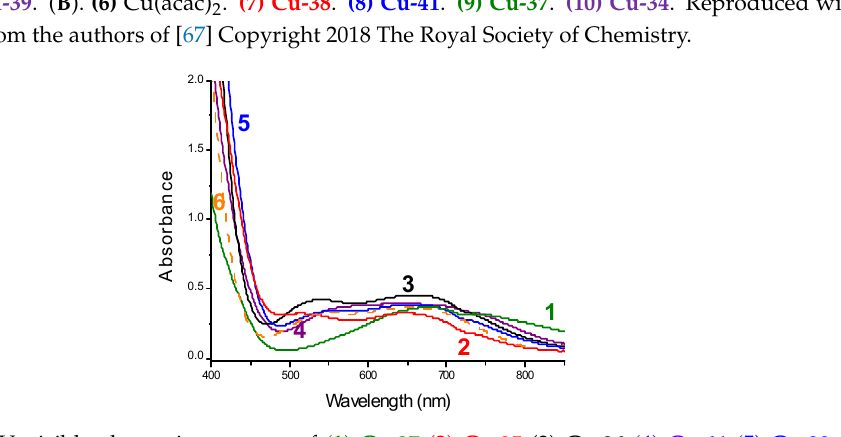
Figure 28. UV–visible absorption spectra of (1) Cu-37 (2) Cu-35 (3) Cu-36 (4) Cu-41 (5) Cu-38 (6) Cu(acac ) 2. Reproduced with permission from the authors of [67] Copyright 2018The Royal Society of Chemistry.